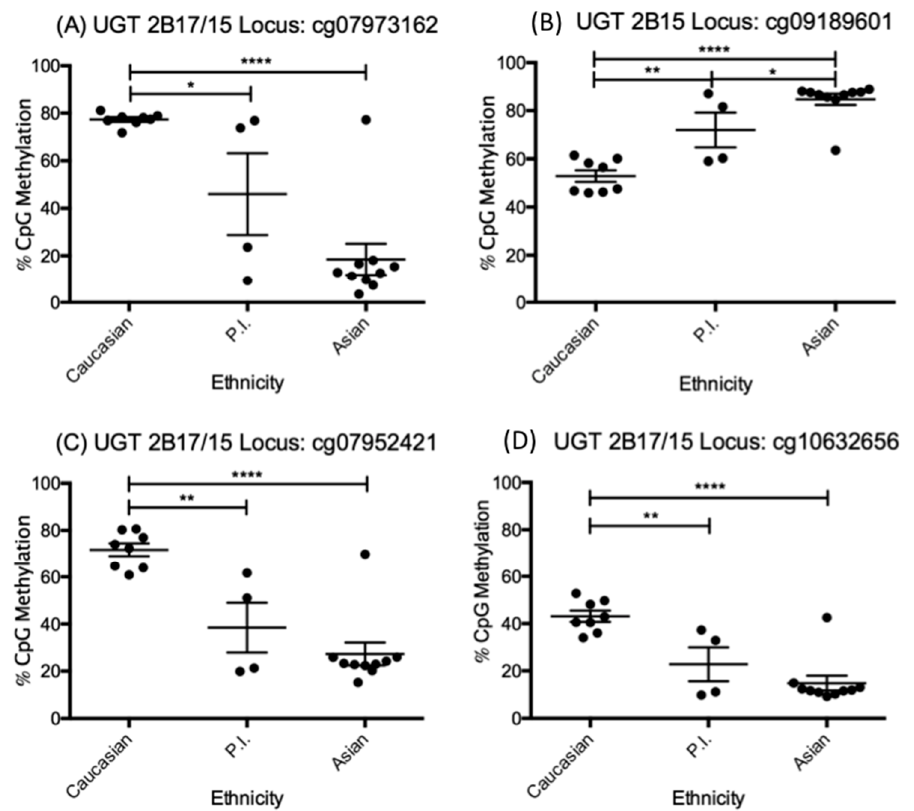
Figure 2. Graphs showing beta values ( β ) for differentially methylated loci associated with UGT2B15 and 2B17, grouped according to ethnicity with separate columns for Caucasians ( n = 8), Pacific Islanders (PI, n = 4) and Asians ( n = 10). The UGT isoform and the specific loci where the methylation is taking place are listed in the title for each individual graph such that loci cg07973162 (A) , cg10632656 (B) , cg07952421 (C) , and cg09189601 (D) show different patterns of methylation between Asians, PI and Caucasians for UGT2B15 and UGT2B17. Statistical significance is listed for p -values ≤ 0.05 (*), ≤ 0.01 (**), and ≤ 0.0001 (****). As compared to PCR, two samples (one Caucasian and one Asian) were lost to analysis due to low sample quality.